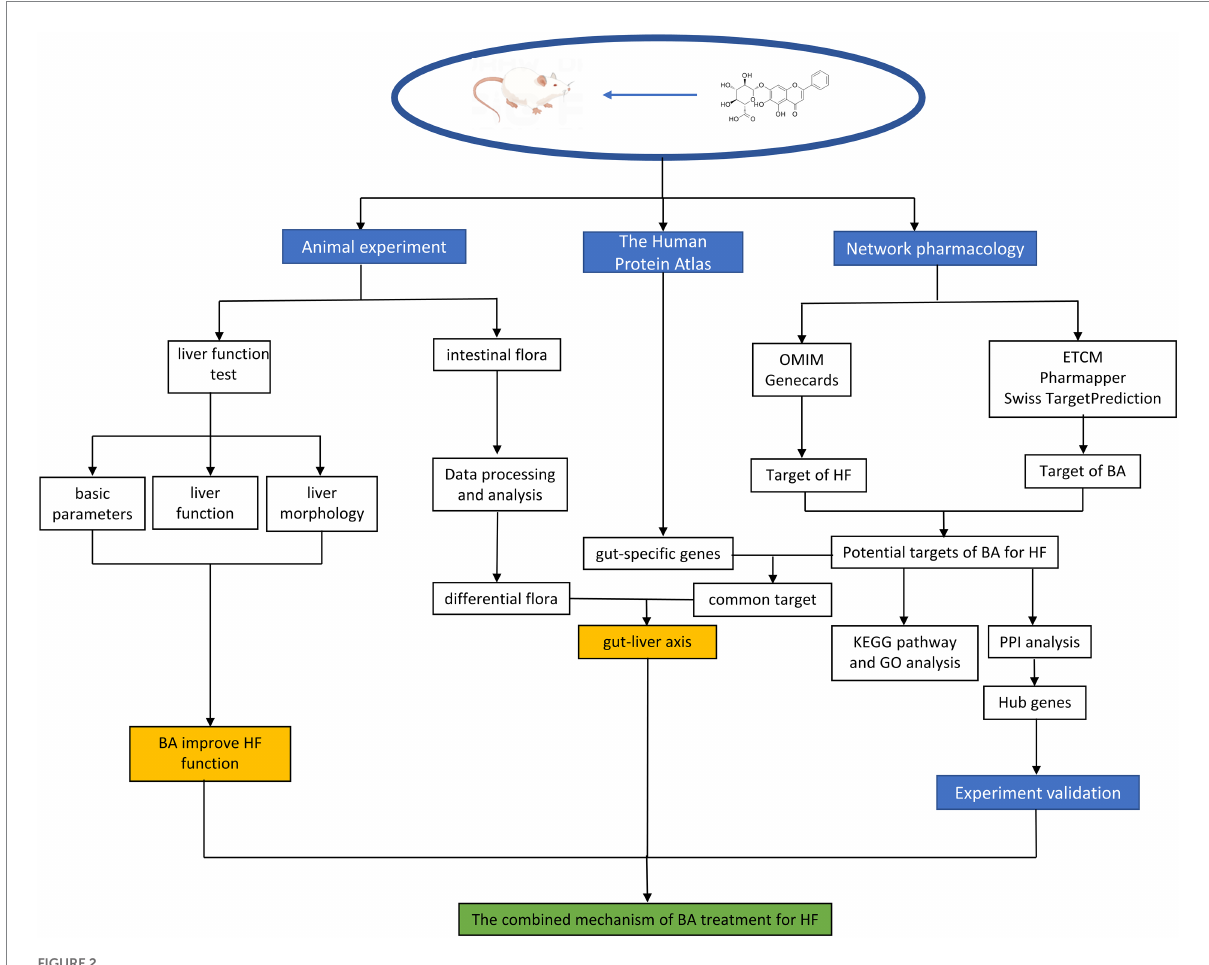
FIGURE 2 Flowchart of the